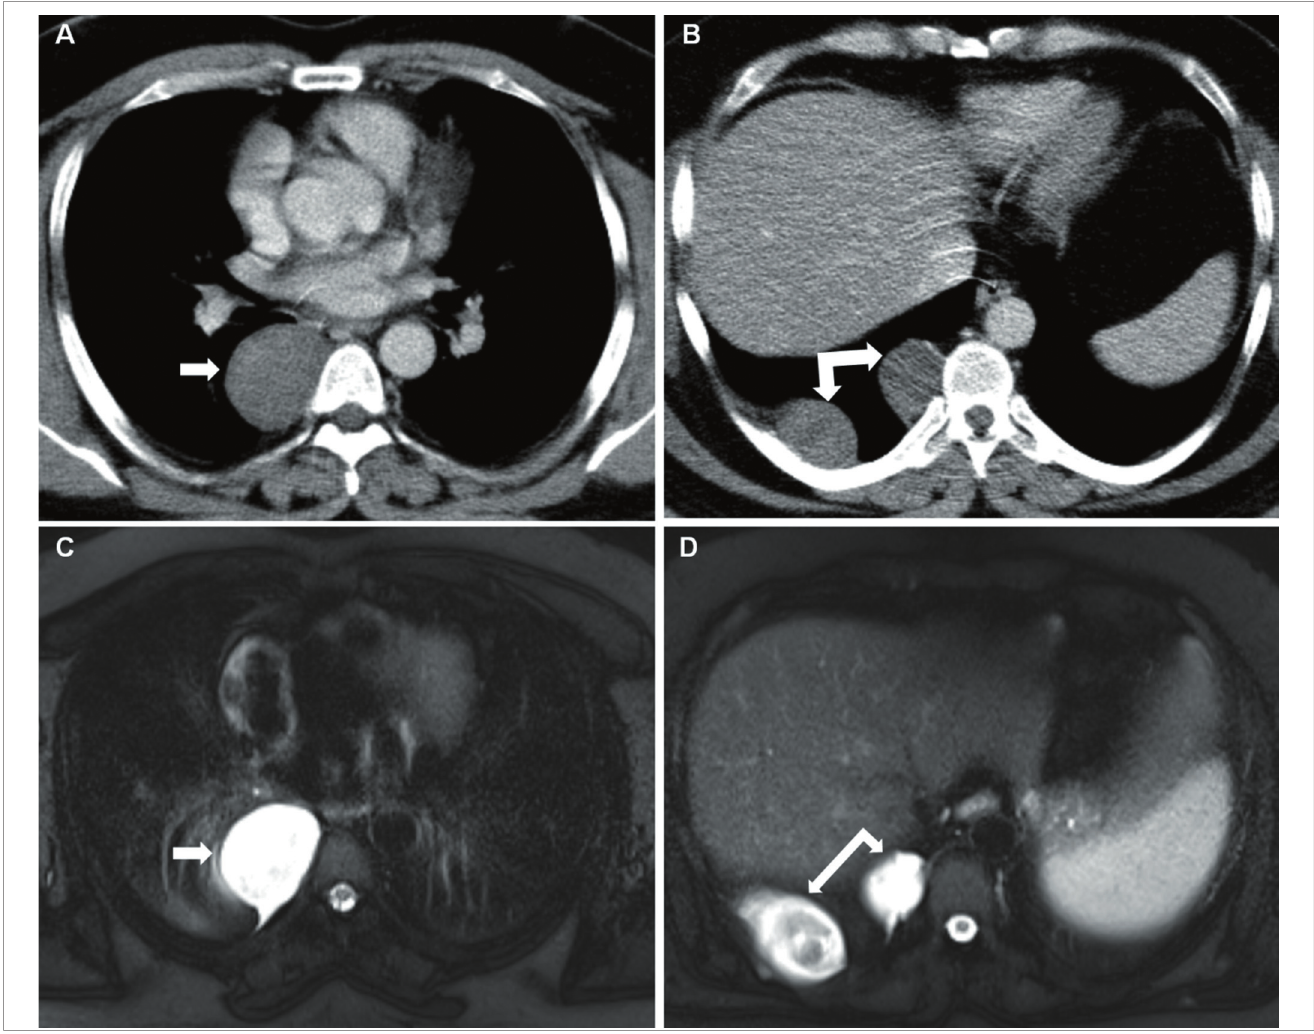
Figure 3. In a 42-year-old male case, hypodense mass appearances with three soft tissue densities, the largest of which is 77 × 39 mm in size with a pleural base, extra- axial located on the right, are observed on thoracic CT (A, B). The lesion causes destruction and invasion in the adjacent rib. In MRI, it was determined that the lesion caused partially restricted di ff usion and increased heterogeneous contrast enhancement on postcontrast sections (C, D). Neuro fi broma was detected in the histopathological examination of the